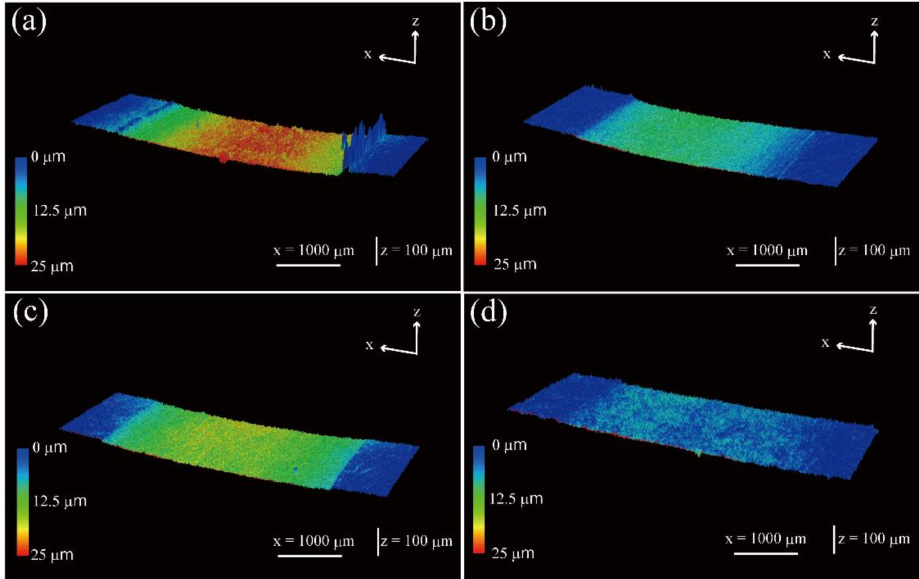
Figure 11. Three-dimensional profiles of the worn surface of polymer composite specimens after the sliding wear test against carbon steel S45C of various surface-treated HF/PA1010 biomass composites: